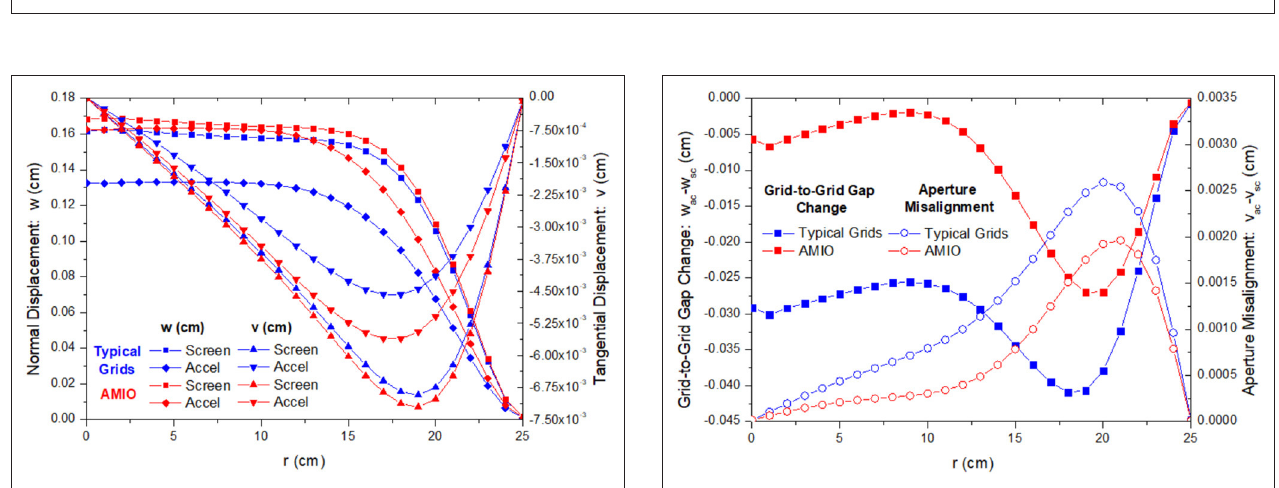
FIGURE 6 | Representation of the grid-to-grid gap change for ion optics when screen grid and accel grid have the same CTE (upper part) and when the CTE of accel grid is higher than screen grid’s (lower part) .